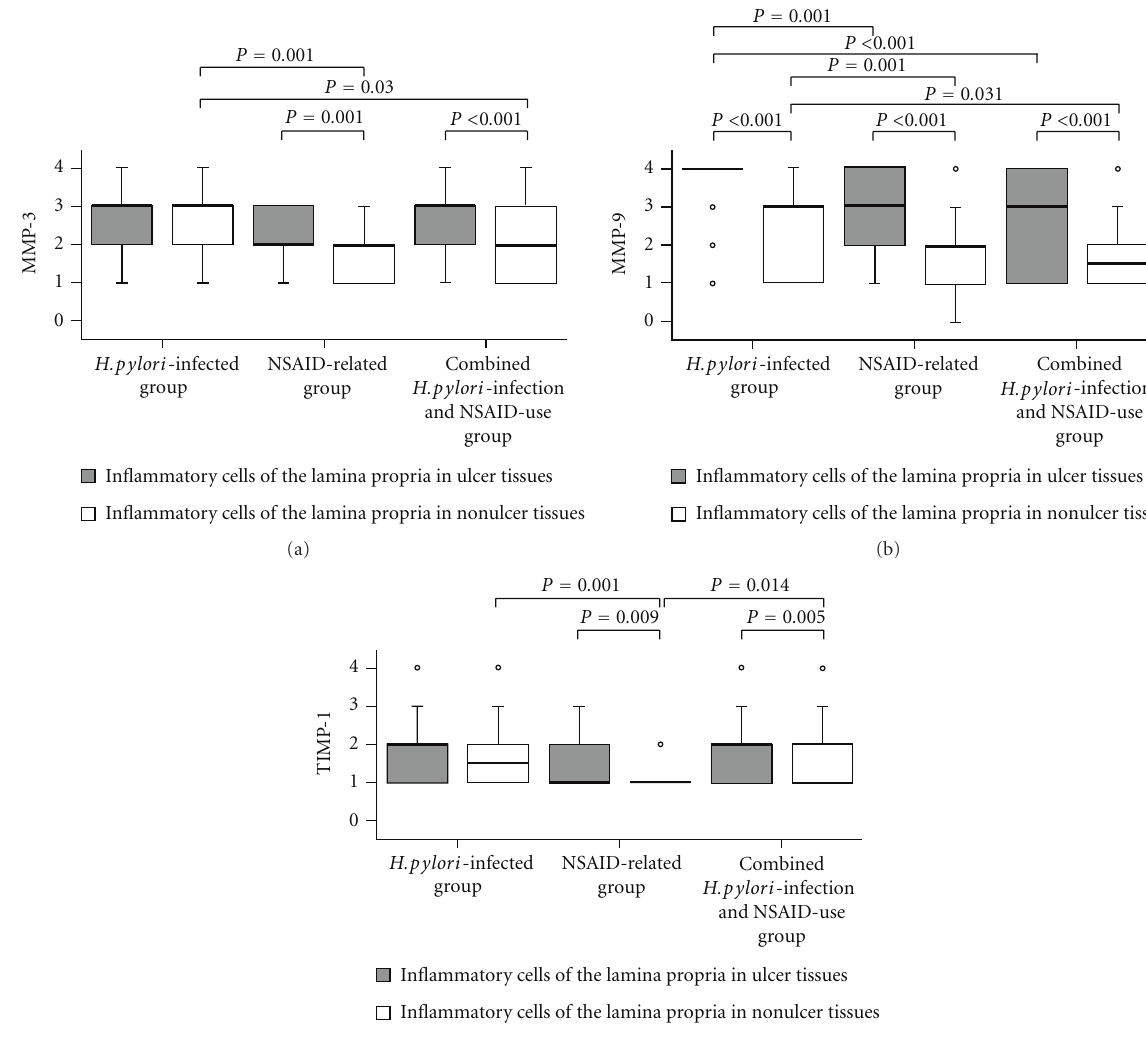
Figure 3: Box plots of the distributions and median scores of MMP-3, MMP-9, and TIMP-1 in inflammatory cells of the lamina propria of gastric ulcer tissues and nonulcer tissues in di ff erent groups, respectively. The P values compared scores according to patients in the H. pylori -infected, NSAID-related, and combined H. pylori -infection and NSAID-use groups by Mann-Whitney U test and also compared scores according to ulcer tissues and nonulcer tissues by Wilcoxon signed-rank test. In the box plots, the 75th and 25th percentiles are represented by the top and bottom of the box, respectively. The horizontal lines refer to the medians. Abbreviations are as in Figure